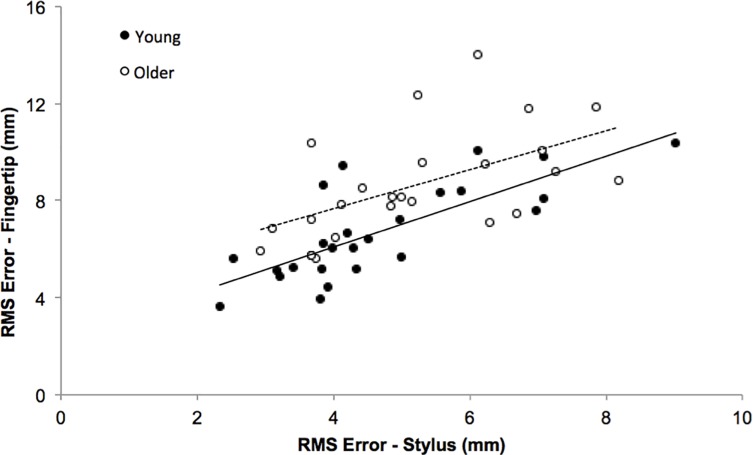
Relationship between RMS error on the spiral tracing task using the index finger vs. stylus.Though RMS error with the index fingertip and stylus were significantly correlated for the young (r2 = 0.588; p < .001) and older adults (r2 = 0.350; p = .002), the decreased correlation for older adults indicates that additional factors may be responsible for the age-related differences in RMS error while using the fingertip.